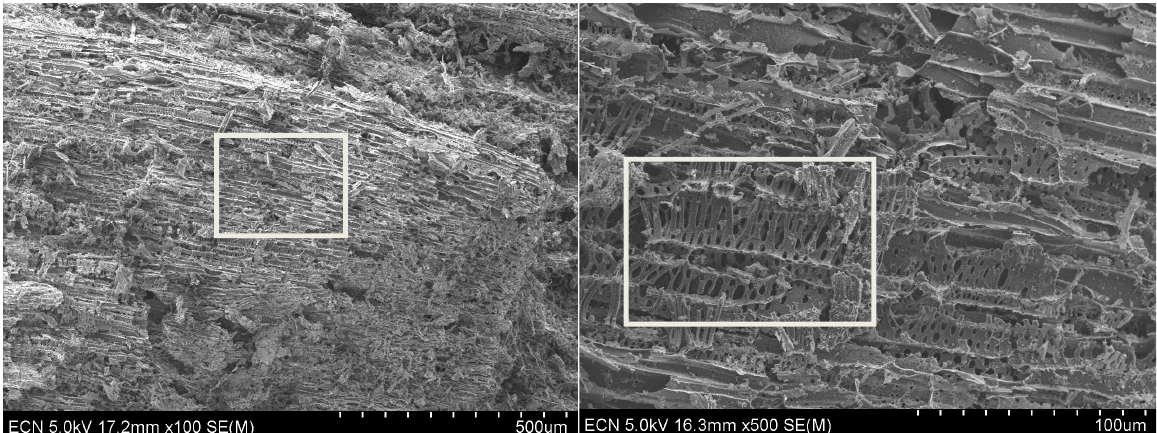
Figure 9. SEM microscopy photographs from the greenhouse waste from pepper (GHW) 1 biochar samples produced in the larger lab-scale